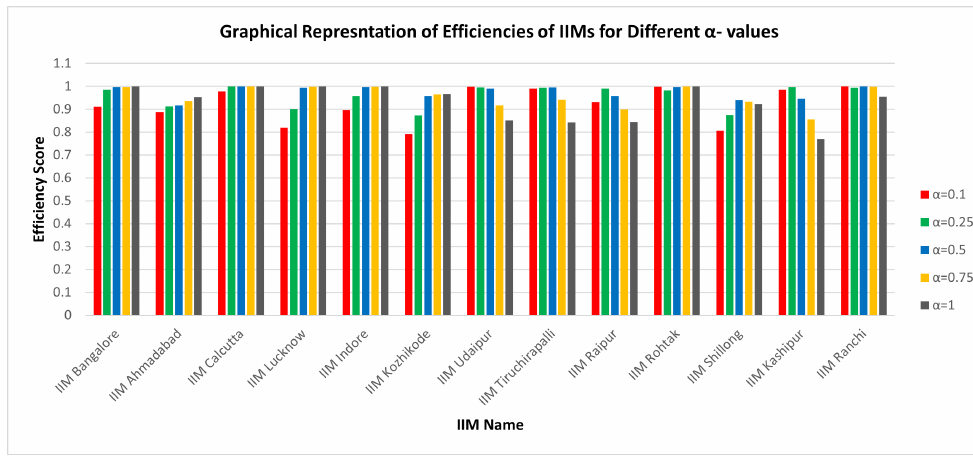
Figure 3. Graphical representation of efficiencies of IIMs for different α -